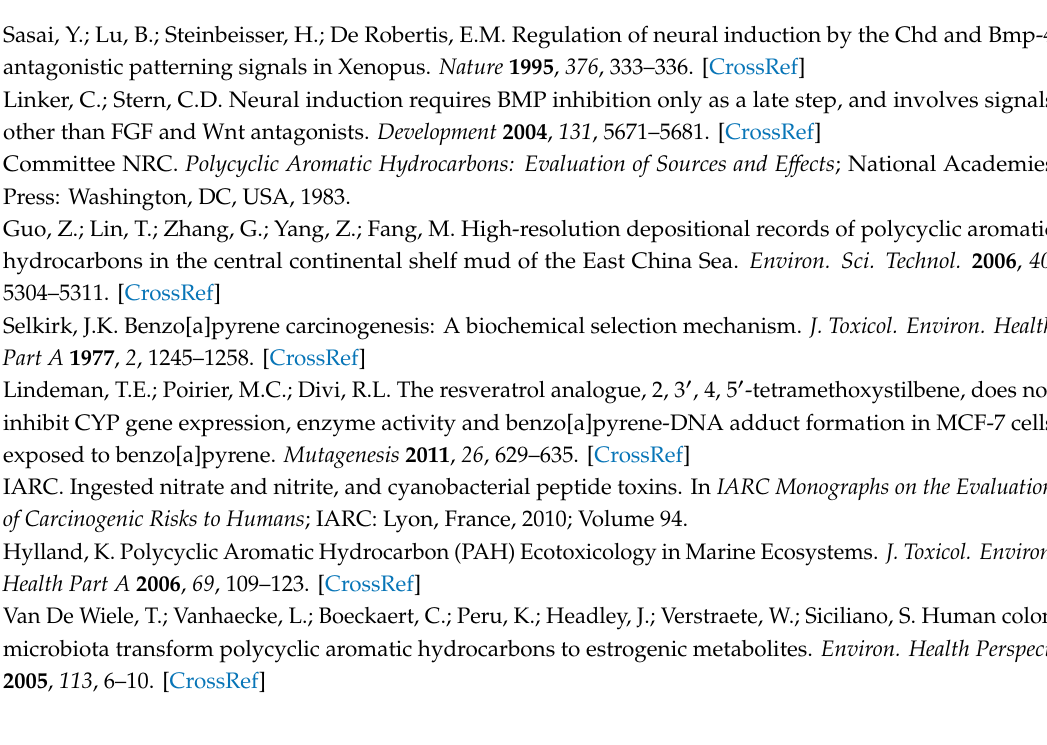
Figure S1: Sense riboprobe serves as negative controls for in situ hybridization staining